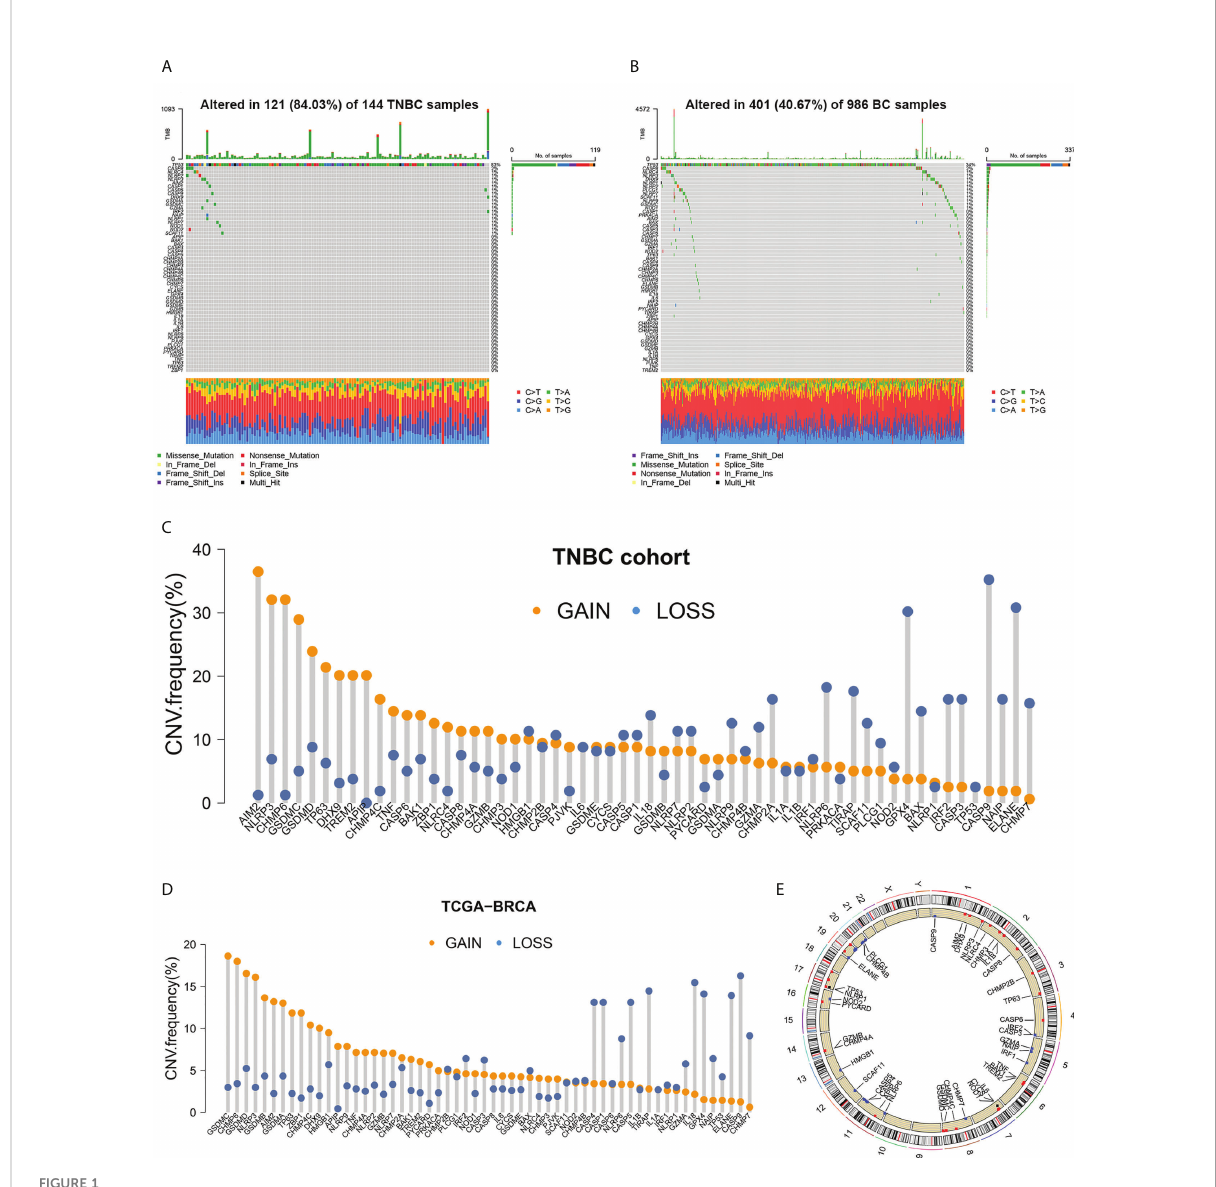
FIGURE 1 Somatic mutation analysis of PRGs. (A, B) Mutation frequencies of 58 PRGs in TNBC samples and all BC samples. (C, D) Copy number variations of 58 PRGs in TNBC samples and all BC samples. (E) Copy number alteration loci of PRGs on 23 chromosomes in TNBC